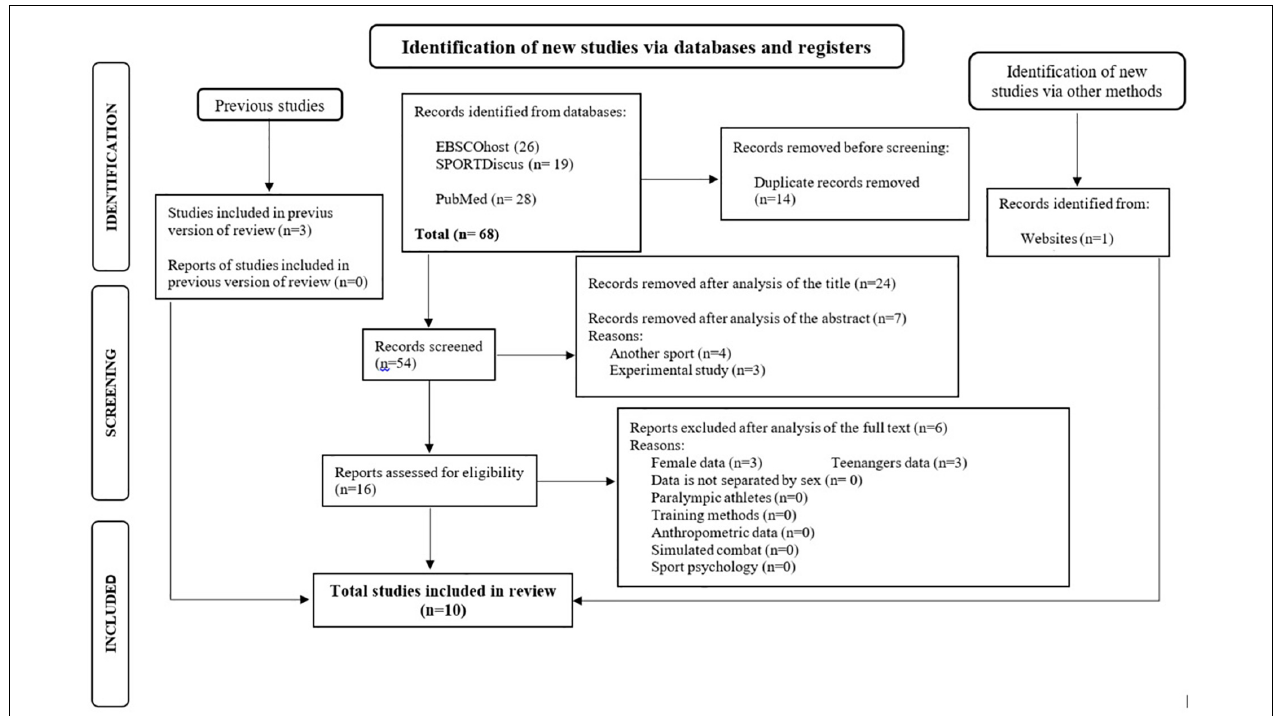
FIGURE 1 | Prisma flow diagram for study